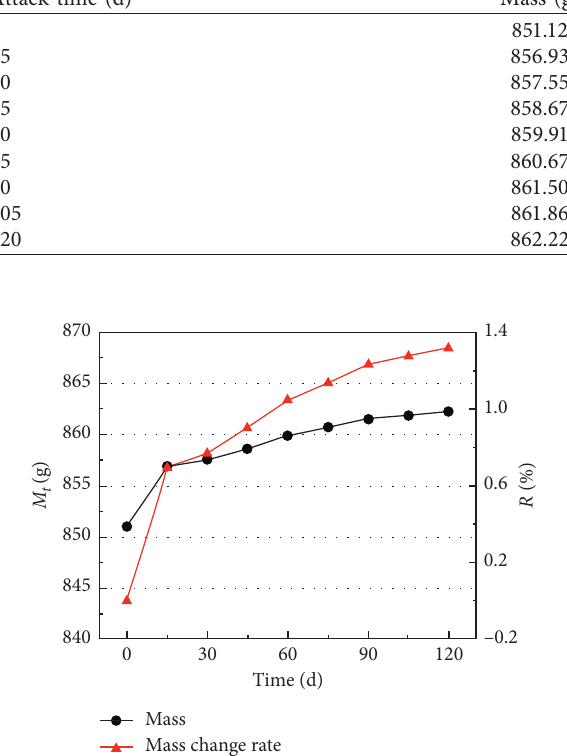
Figure 7: Mass change curve of concrete specimens with attack